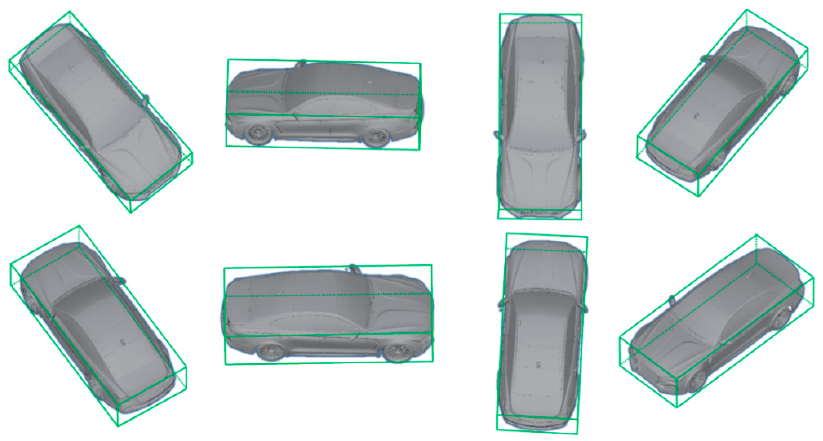
Figure 8. The 3D box viewpoint of the vehicle (four vertices corresponding to four 2D box edges) ( left ) and dimensions of vehicle at original position in the world coordinate system ( right ).